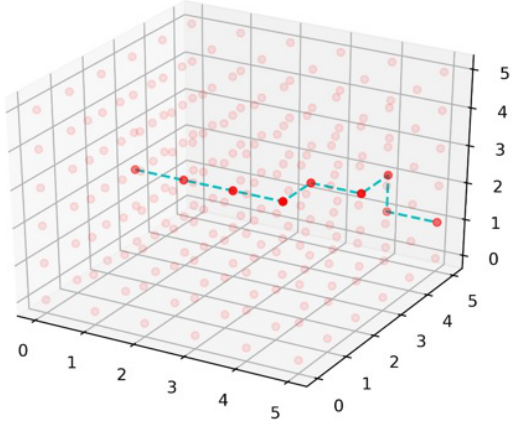
Figure 12. 3D-directional greed